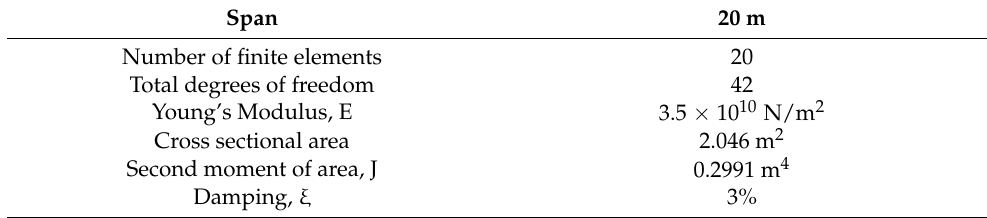
Table 1. Properties of bridge